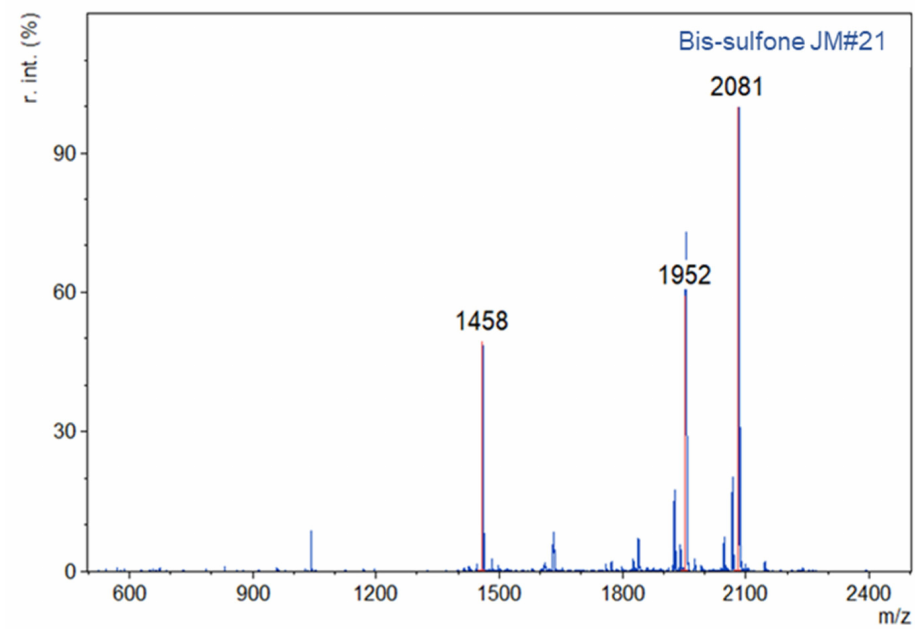
Figure A3. MALDI-TOF-MS of bis-sulfone-JM#21 (+), m/z: [M + H] + = 1952 (monosulfone), [M + H] + = 2081 (bis-sulfone). Preparation of HSA-peptide conjugates .